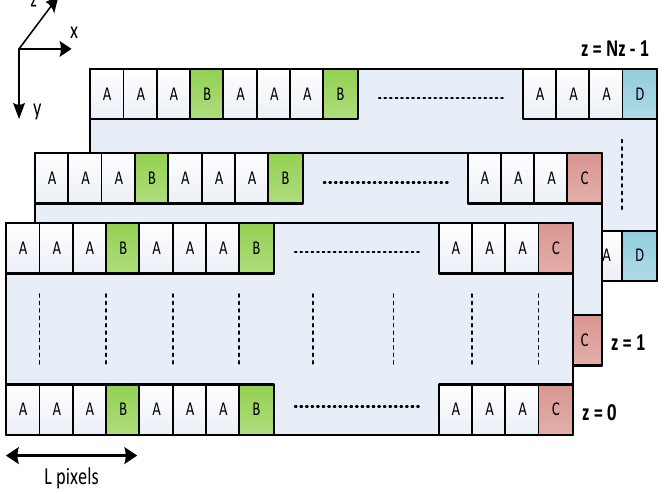
Figure 4. Pixel classification in the lossy compression